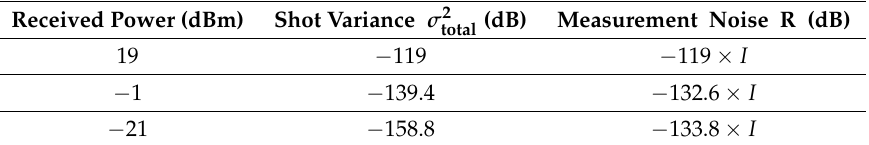
Figure 5. Relation between the estimation error, the received power, the shot noise and the total measurement noise using ( a ) Kalman filter and ( b ) minimax filter. Table 2. The received power, the total noise covariance and the total measurement noise R , according to the simulation